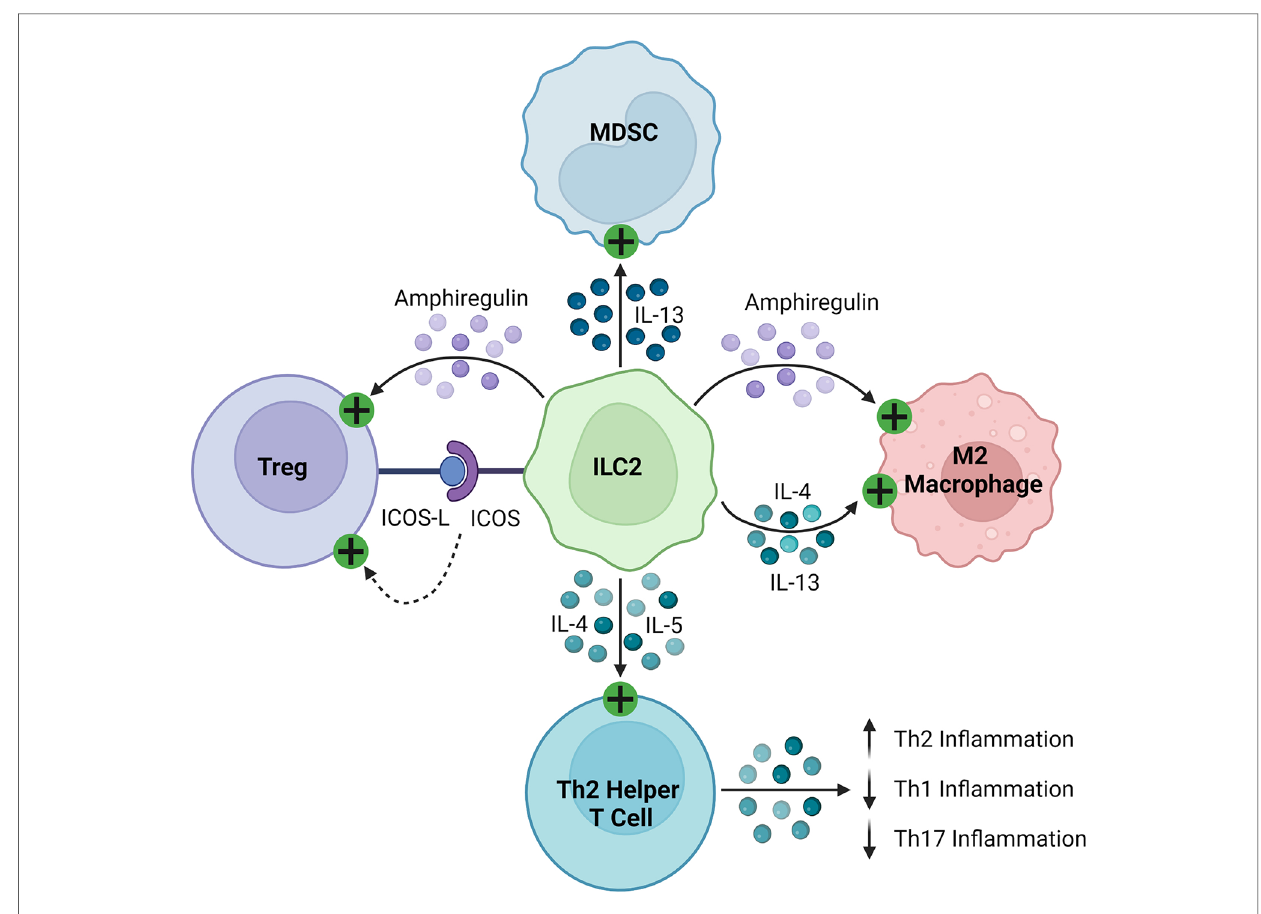
FIGURE 4 Immunosuppressive mechanisms of ILC2s. ILC2s express ICOS and activate Tregs by binding their cognate ICOS-L. They secrete amphiregulin, which activates Tregs and M2 macrophages. ILC2s produce IL-4, IL-5, and IL-13, which then stimulate MDSCs, M2 macrophages, and Th2 helper T cells, promoting a Th2 polarized in fl ammatory